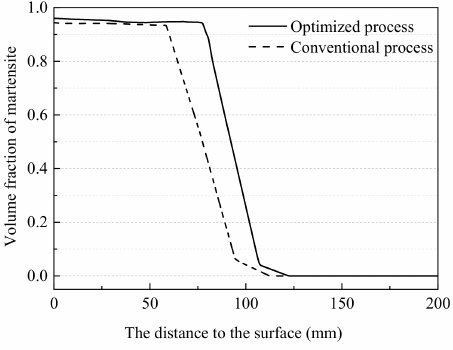
Figure 6. Measured martensite distribution